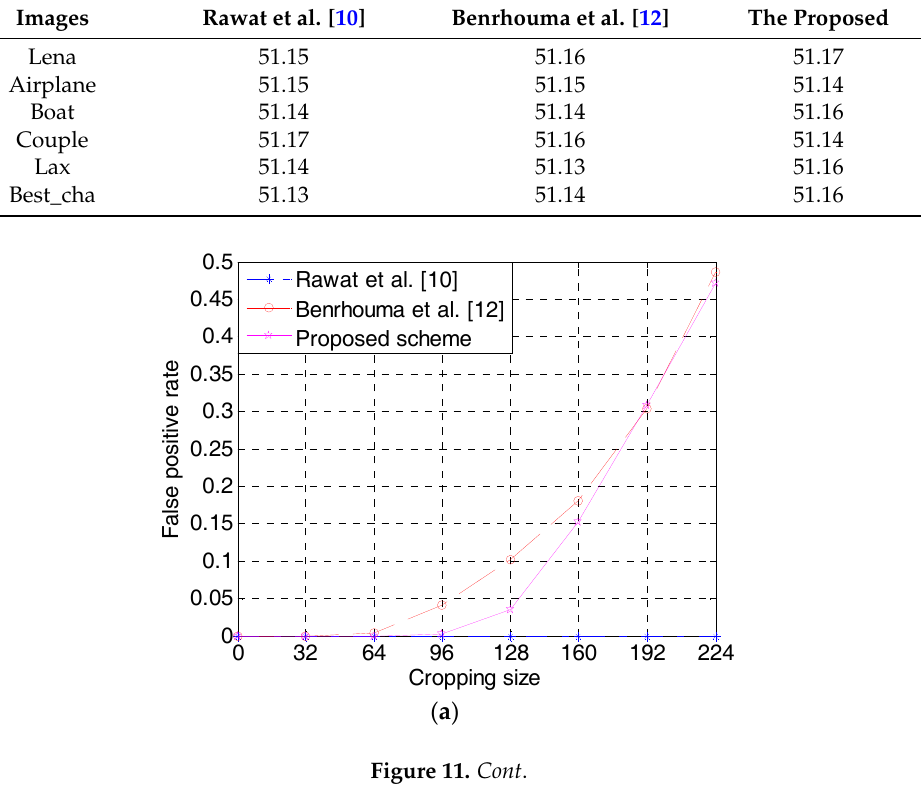
Table 1. Comparison results of peak signal-to-noise ratio (PSNR/dB).